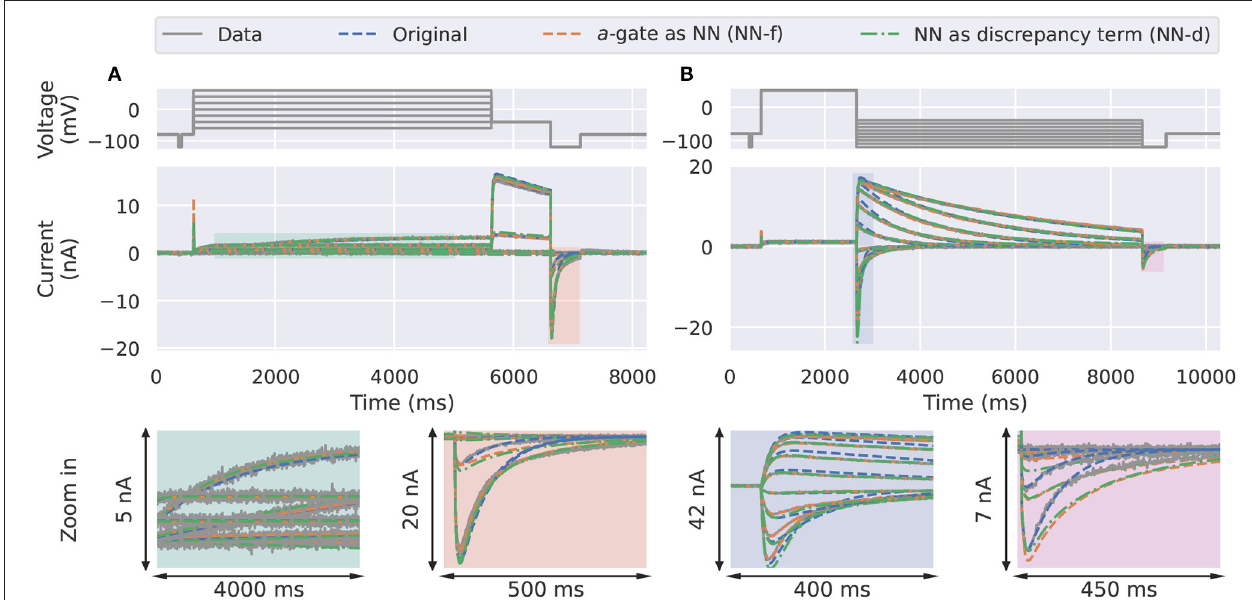
FIGURE 3 | Training results for the synthetic data studies. The training data generated using the ground truth model (grey) are compared against the original candidate model (blue), the a -gate modelled using a neural network (NN-f, orange), and the a -gate with a neural network discrepancy term (NN-d, green). (A) Shows the activation steady-state protocol (Pr3) and (B) shows the deactivation time constant protocol (Pr5). The top panels show the voltage-clamp protocols, the middle panels show the currents, and the bottom panels show the magnification of part of the currents. All figures with a blue background are synthetic data